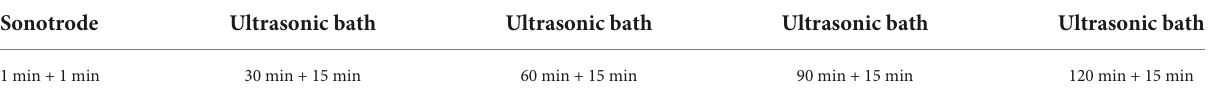
TABLE 1 Sonication methods and times (primary and secondary) of